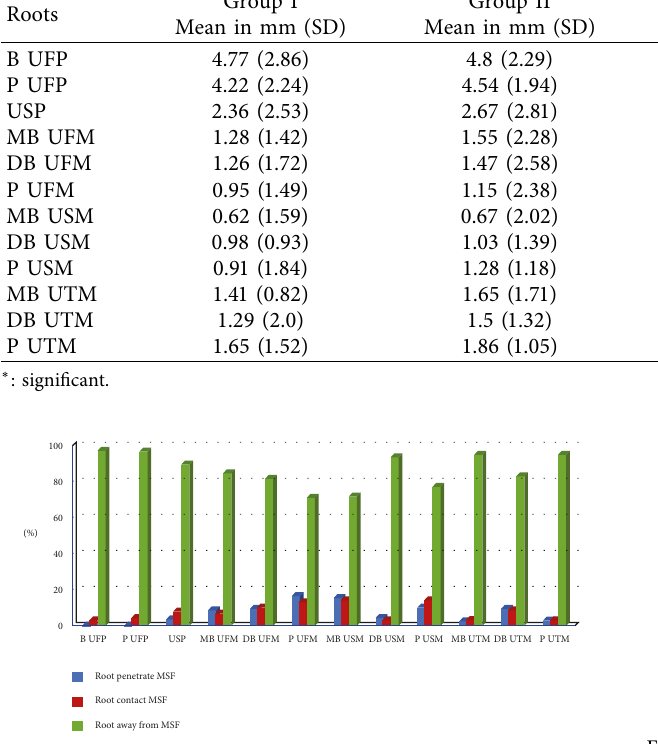
Figure 3: Percent of maxillary posterior roots according to Didilescu